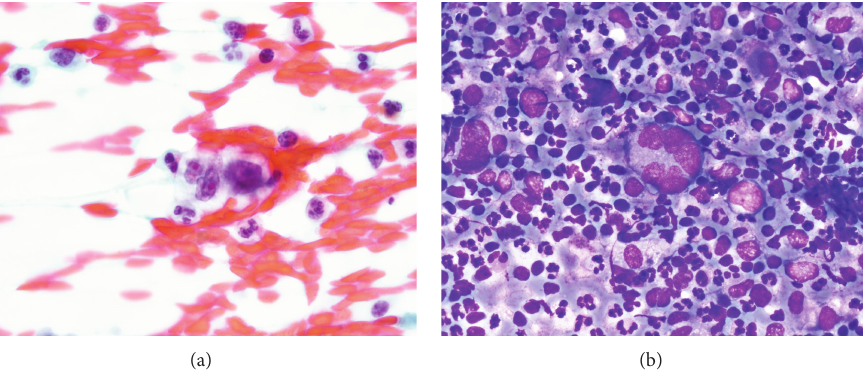
Figure 1: Pathology microscopy of FNA of the chest wall lesion on presentation: (a) 100x magnification, Papanicolaou stain: Reed-Sternberg cell in a mixed inflammatory background, and (b) 60x magnification, Diff Quik (modified Giemsa) stain: Reed-Sternberg cell in a mixed inflammatory background consisting of neutrophils, histiocytes, and small